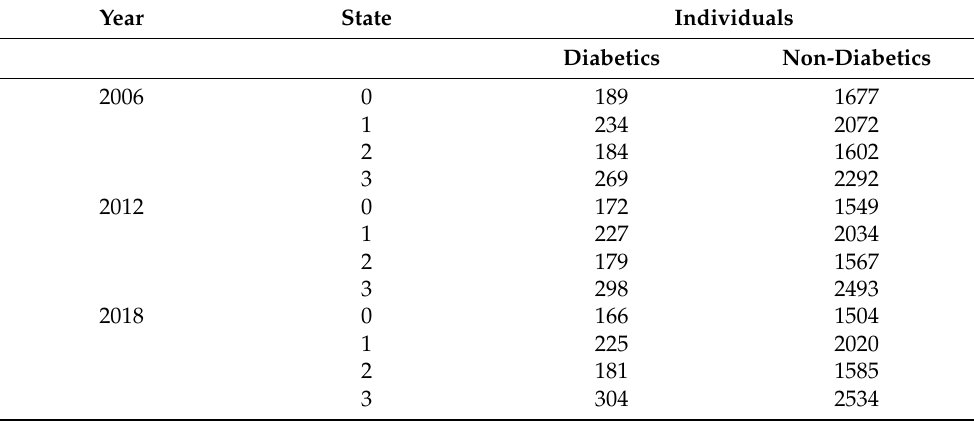
Table 3. Number of individuals by states of deprivation in 2006, 2012, and 2018.